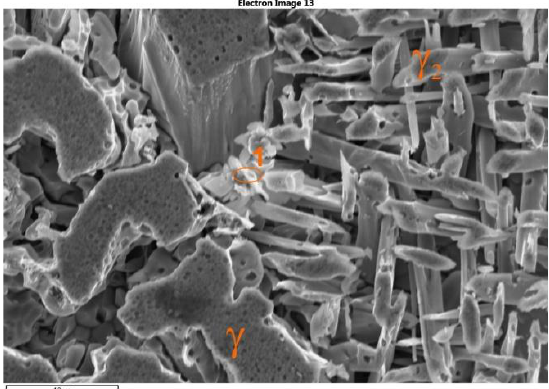
Figure 10. Example of precipitates of γ and γ 2 phases in microstructure of tested cast steel after deep etching (at 900 ° C for 3 h) (scanning microscope). Table 3. Chemical composition at examined points — Figure 10.